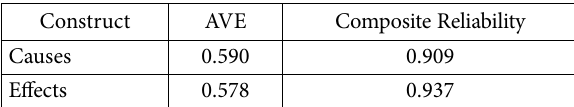
Table 5. Results summary of item loading, AVE and